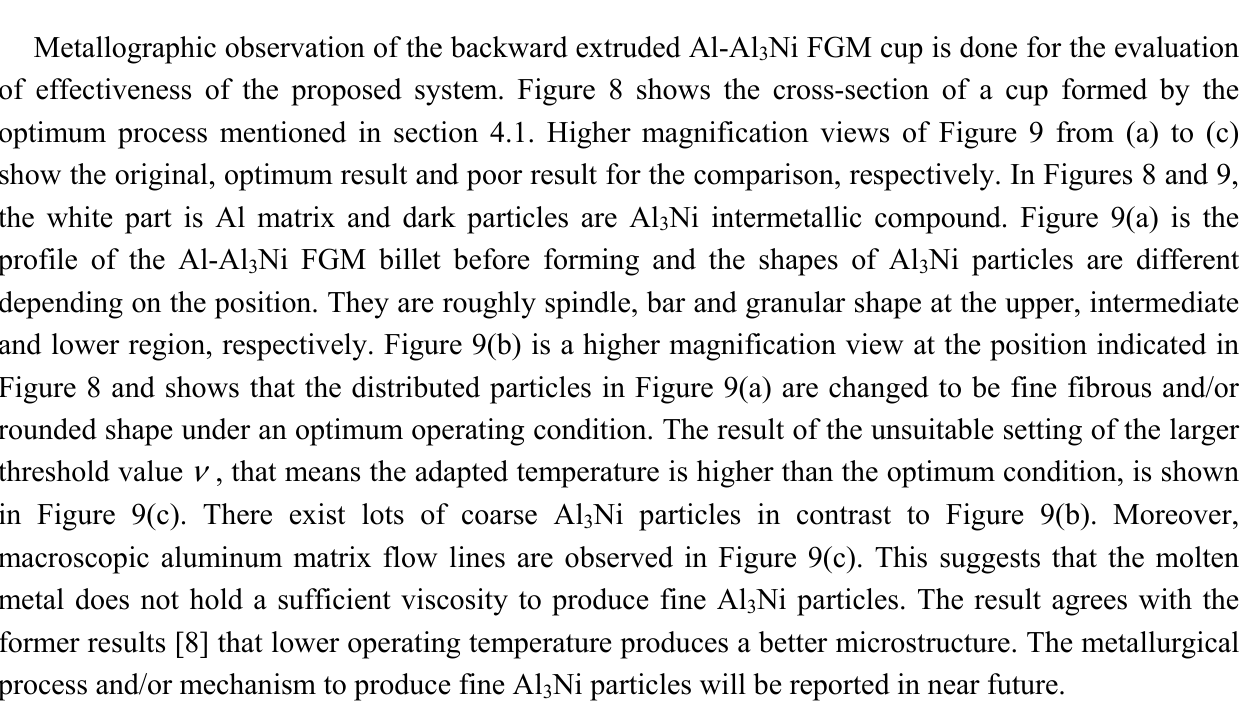
Figure 8. Micrographs showing the profile of the intermetallics in Al phase after